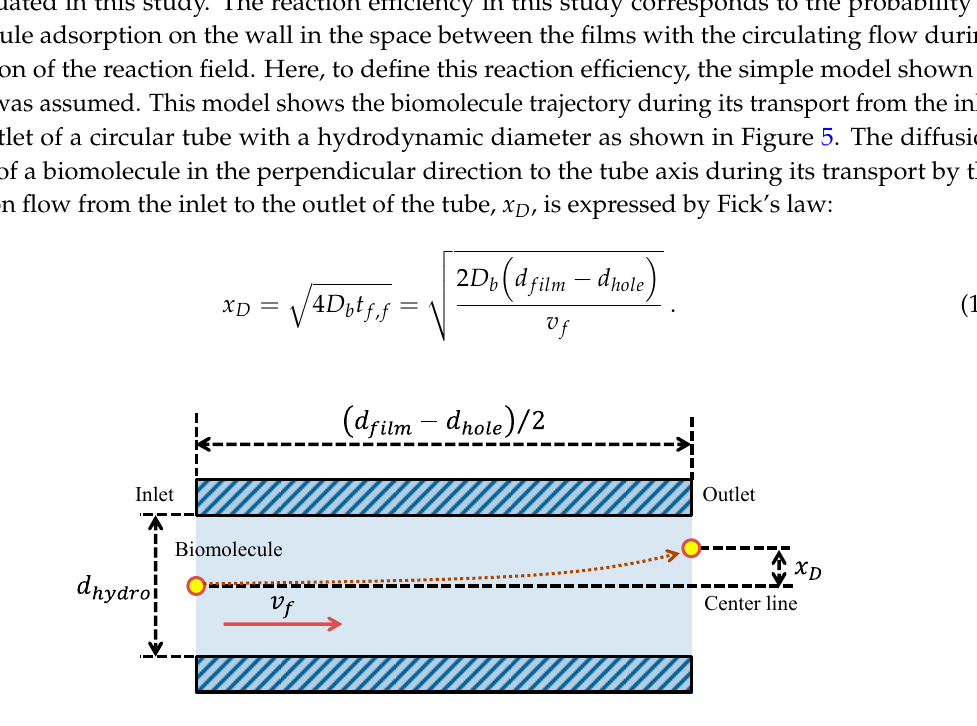
Figure 6. Model of the biomolecule trajectory in a circular tube with a hydrodynamic diameter as shown in Figure 5. x D is the diffusion distance of a biomolecule during its transport by the convection flow from the inlet to the outlet of the tube.